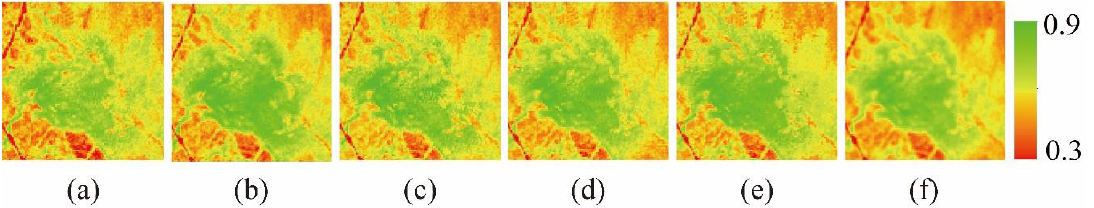
Figure 8. Visual comparison of inset map in the forest area. ( a , b ). Original Landsat_NDVI inset map on 12 August and 11 July 2001; ( c – f ). Predicted Landsat_NDVI inset map by ESTARFM, NDVI-LMGM, FSDAF and NDVI_FMHC. Table 2. Accuracy comparison of four fusion methods in forest area.